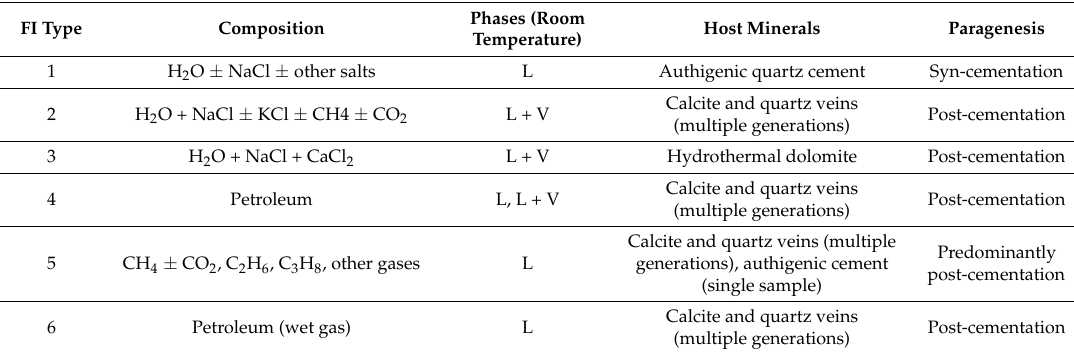
Table 2. Characteristics of fluid inclusion types.